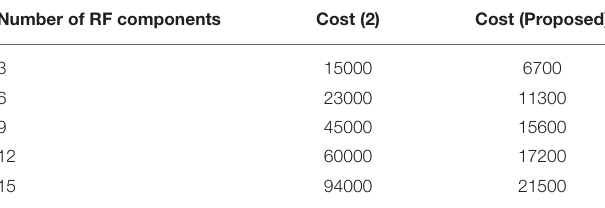
TABLE 5 | Cost of existing and proposed